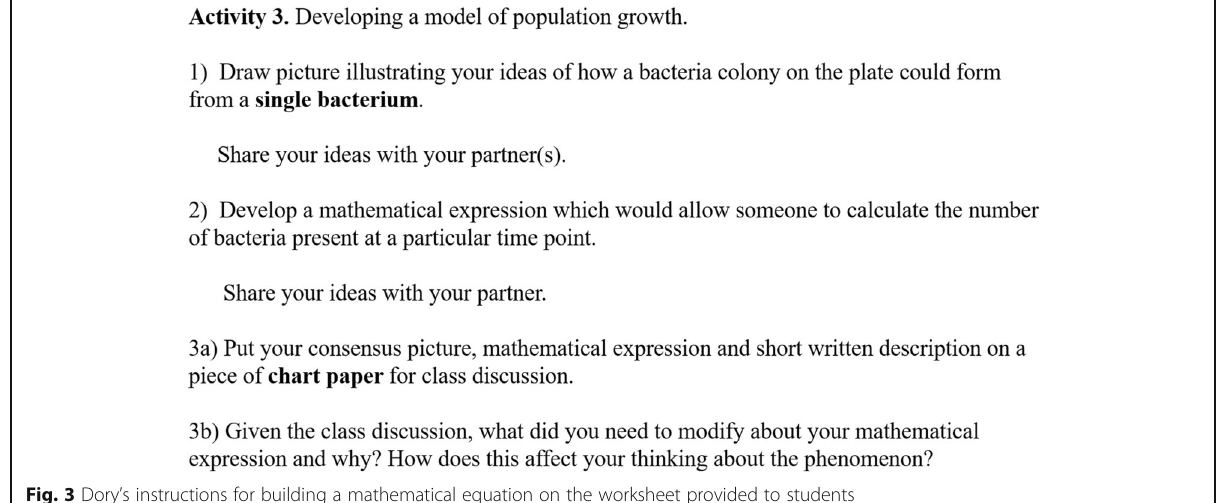
Fig. 3 Dory ’ s instructions for building a mathematical equation on the worksheet provided to